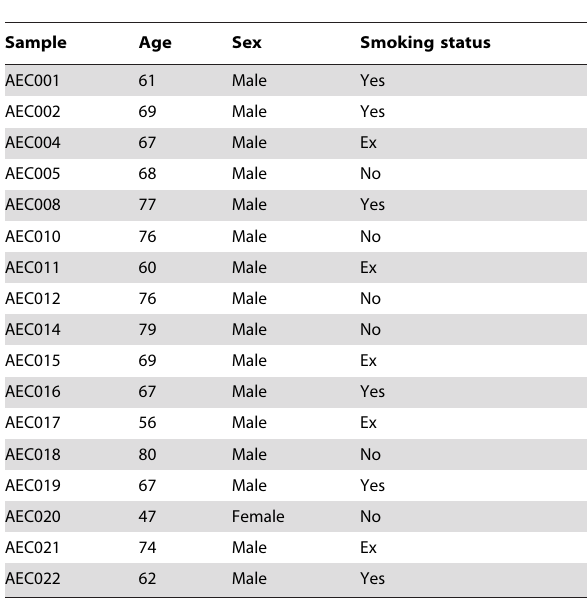
Table 1. Characteristics of malignant mesothelioma patients (MMP).